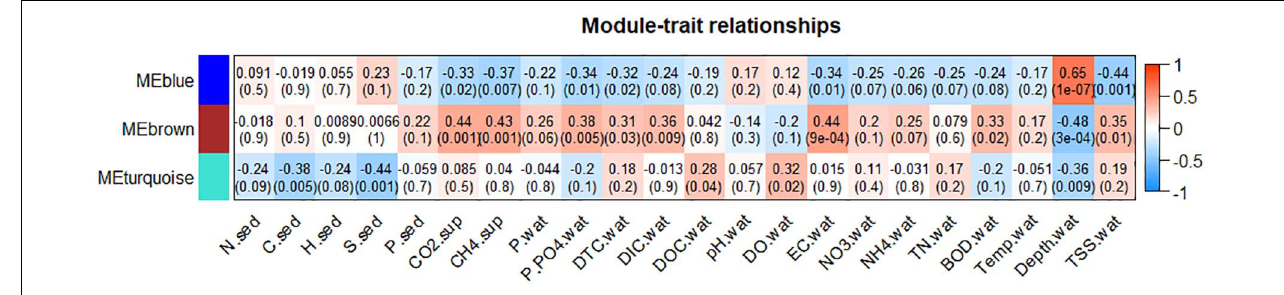
FIGURE 6 | Correlations between eigen genes modules and limnological variables. sed, sediment; wat, water; sup, air-water interface.